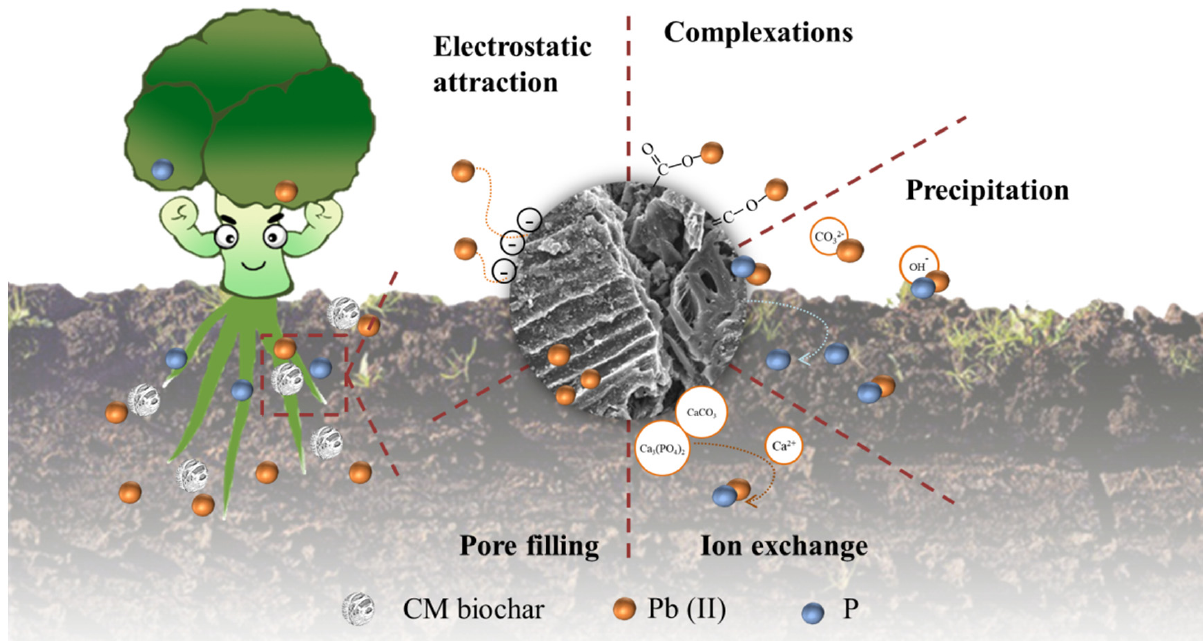
Figure 8. Surface interaction between Pb(II) and CM functional materials.